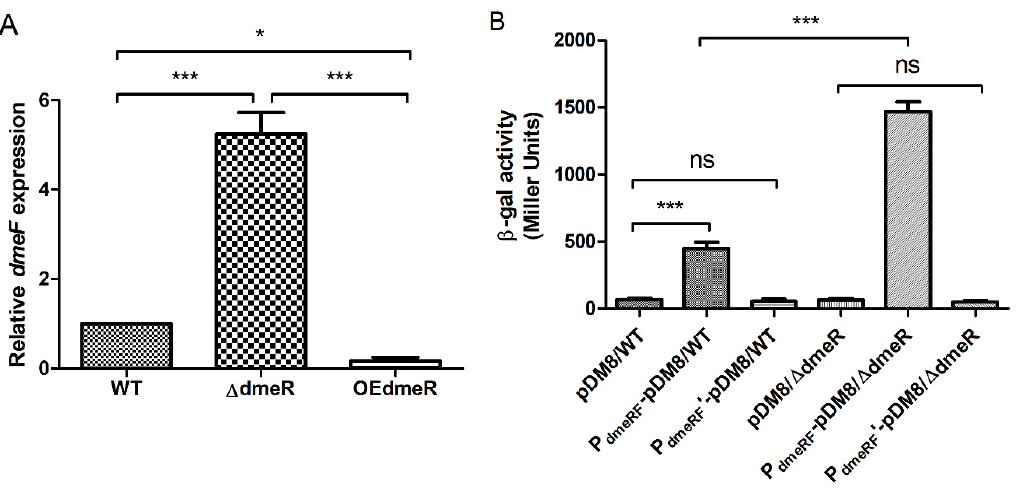
Figure 7. DmeR regulates the dmeRF operon. ( A ) qRT-PCR analysis of dmeF expression in the WT, Δ dmeR , and OE dmeR strains. Results represent the means and SD from three biological replicates. ( B ) Assays measuring the β -galactosidase activities of early-exponential phase cells of the WT and